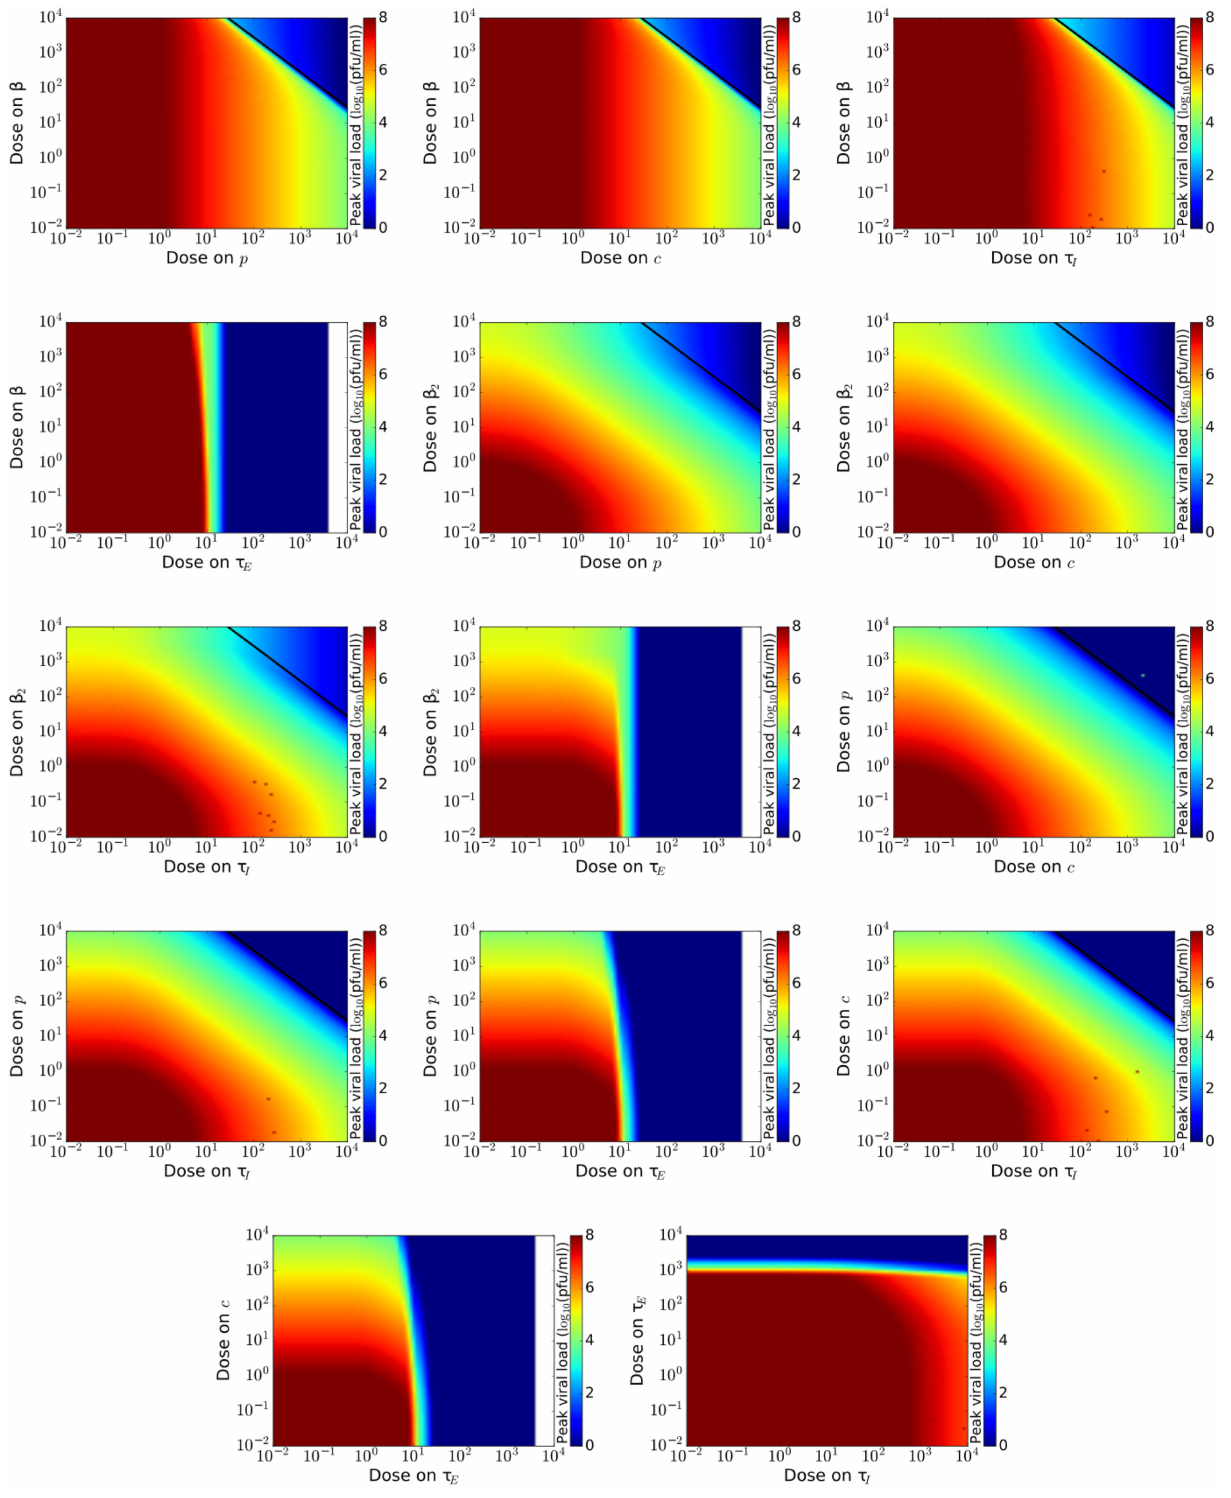
Frontiers in Pharmacology | www.frontiersin.org